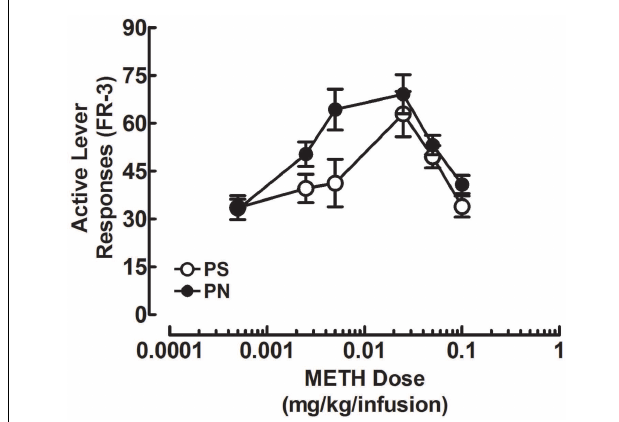
FIGURE 2 | Mean ( ± SEM) active lever responses for the PS and PN groups are presented for the METH doses 0.0005, 0.0025, 0.005, 0.025, 0.05, and 0.1mg/kg/injection according to a log 10 scale. Data from the training dose, 0.05mg/kg/injection, is shown on the graph as a point of reference, but was not included in the ANOVA.This point represents the average responding for 0.05mg/kg/infusion METH from the day before testing with the 0.0005- to 0.1-mg/kg/infusion doses. PN animals showed a leftward shift of the dose-response curve relative to the PS rats [Prenatal Treatment × Dose interaction; F (1, 34) = 4.9, p < 0.05].